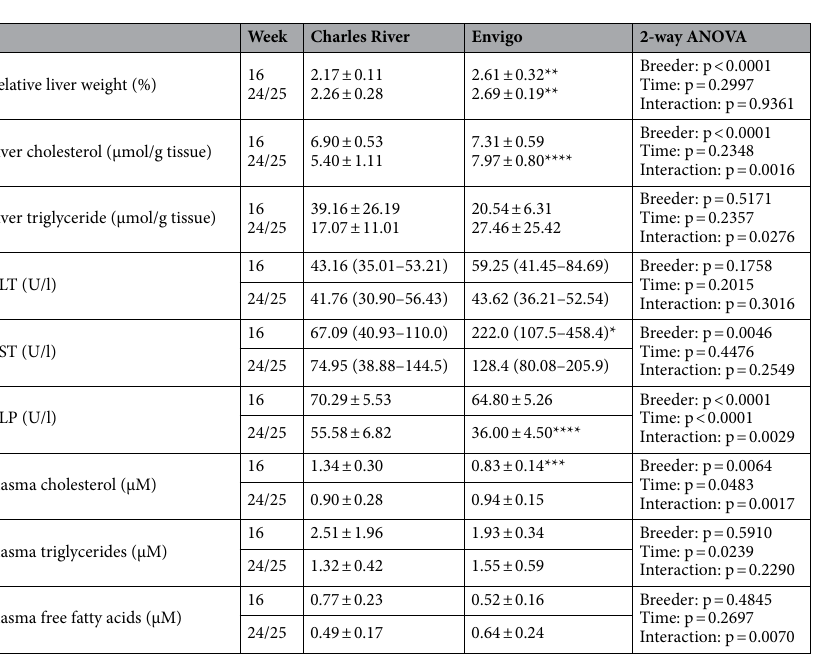
Table 2. Liver status and plasma lipids in healthy chow fed guinea pigs. Means with standard deviations or geometic means with 95% confidence intervals. n Charles River week 16 = 7, n Envigo week 16 = 8, n Charles River week 24/25 = 12, n Envigo week 24/25 = 8. ALP at week 16 n = 5 for Envigo only. ALP alkaline phosphatase, ALT alanine aminotransferase, AST aspartate aminotransferase. *p < 0.05, **p < 0.01 ***p < 0.001 ****p < 0.0001 vs Charles River at same time point. Analysed by two-way ANOVA with Sidak’s multiple comparison